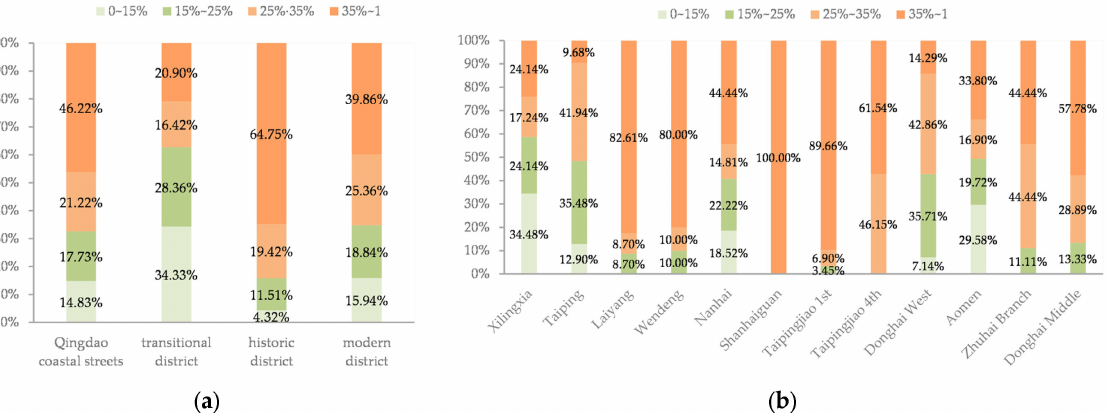
Figure 8. ( a ) Proportions of the 4 GVI levels in the overall Qingdao Coastal Streets and the three types of districts; ( b ) proportions of the 4 GVI levels in the 12